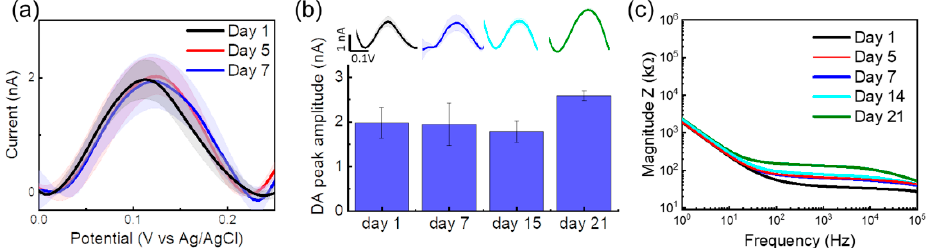
Figure 7. Stable chronic detection of tonic dopamine concentrations using PEDOT/CNT-coated GC MEAs in the mouse DS. ( a ) Baseline-subtracted SWV DA peaks collected from a PEDOT/CNT- coated microelectrode (basal level, mean, and STD of 5 min acquisition sessions) at Days 1, 5, and 7 post-implantation in the mouse DS. ( b ) Bar plot reporting the baseline-subtracted SWV DA peaks at 0.12 V, at Days 1–21 post-implantation in the mouse DS. Average ± SD of the SWV collected over a 5 min recording session, with the respective baseline-subtracted SWV DA peaks (top). ( c ) In vivo electrochemical impedance spectra of the magnitude impedance of a representative PEDOT/CNT- coated microelectrode implanted in the mouse DS at Days 1, 5, 7, 14, and 21 post-implantation.